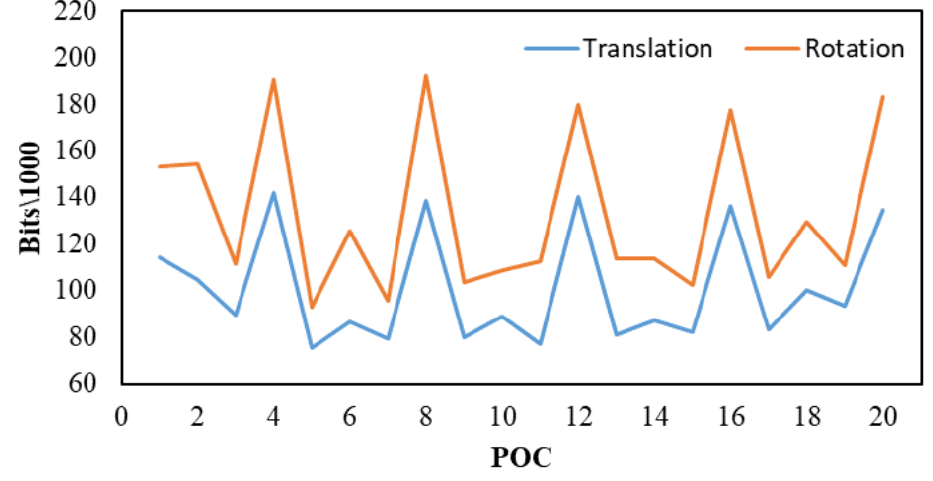
Figure 1. Relationship between camera motions and transmission bits in